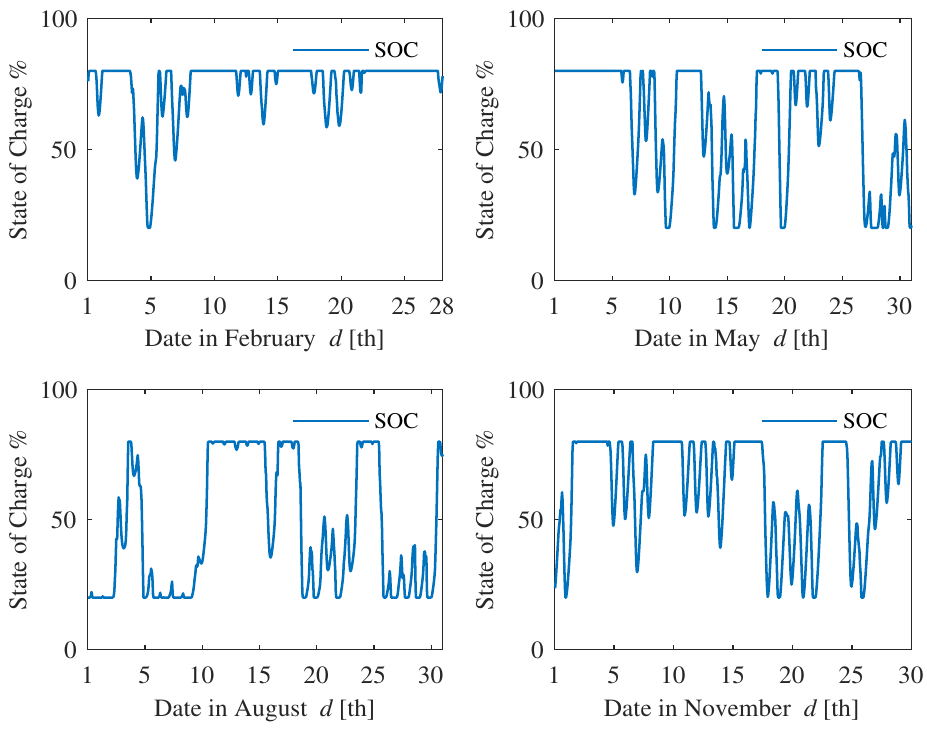
Figure 9. SOC of Case 2 for 4 months. Figure 10 shows the corresponding power generation and power usage in the four seasons, the whole year, and one year of the SOC of the battery bank. The green part is the constant electricity obtained from the grid. Although green occupies a large part, it is difficult to solve these issues. It can be found from the figure that the magenta part protects the peak power of the campus. However, the problem is that this part of the electricity is difficult to consume during the other days. Corresponding to this are the red parts, which represent wasted energy. It can also be found in the figure that in summer, energy waste is less than in spring. From the 50th day to the 100th day, the battery can be regarded as unused. Here, dividing power purchases into summer and spring categories will give better